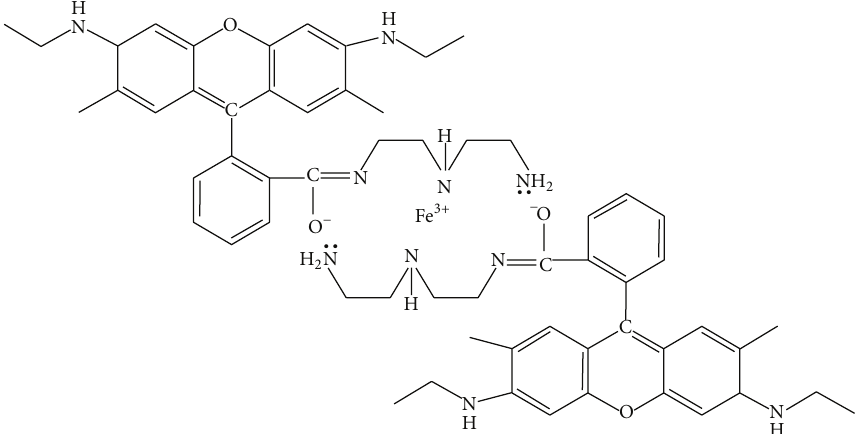
Figure 1: Chelation of FD2 via binding with Fe 3+